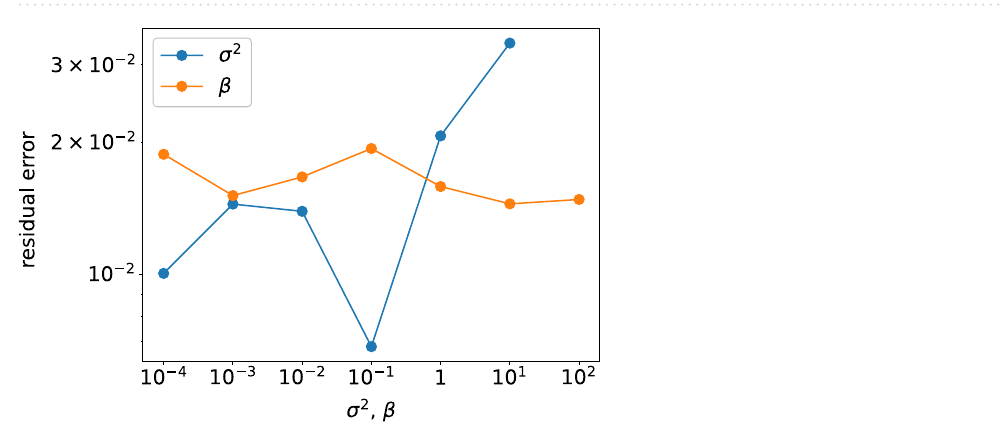
Figure 6. Hyperparameter dependence on the